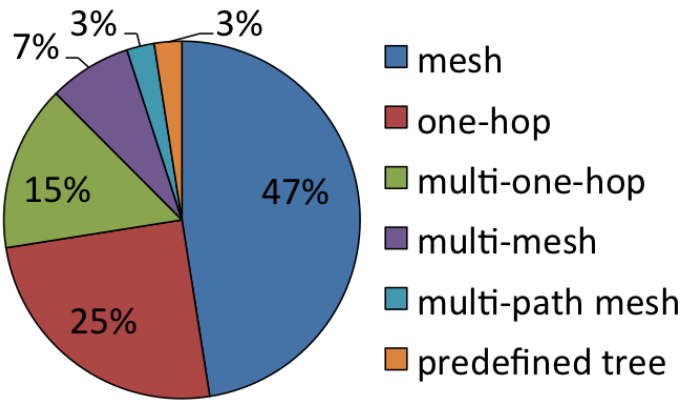
Figure 7. Deployment network topologies —Almost half (47%) use a multi-hop mesh